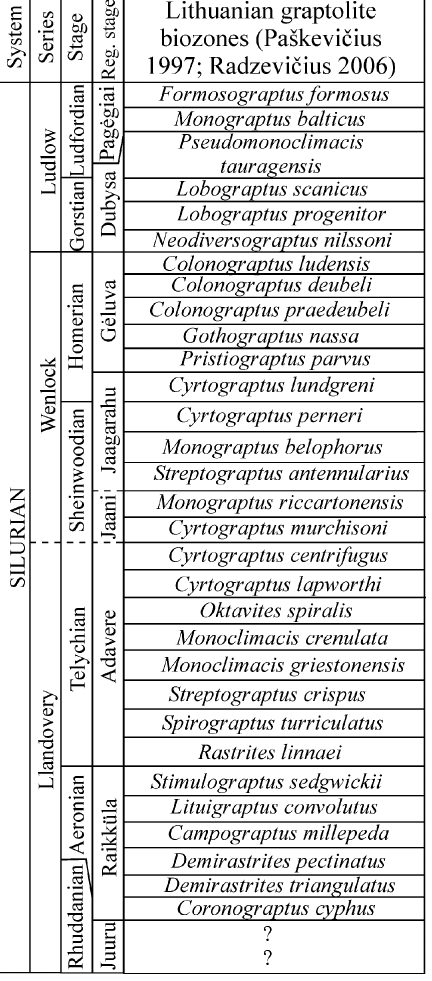
Fig. 3. List of Lithuanian graptolite biozones mentioned in text and in